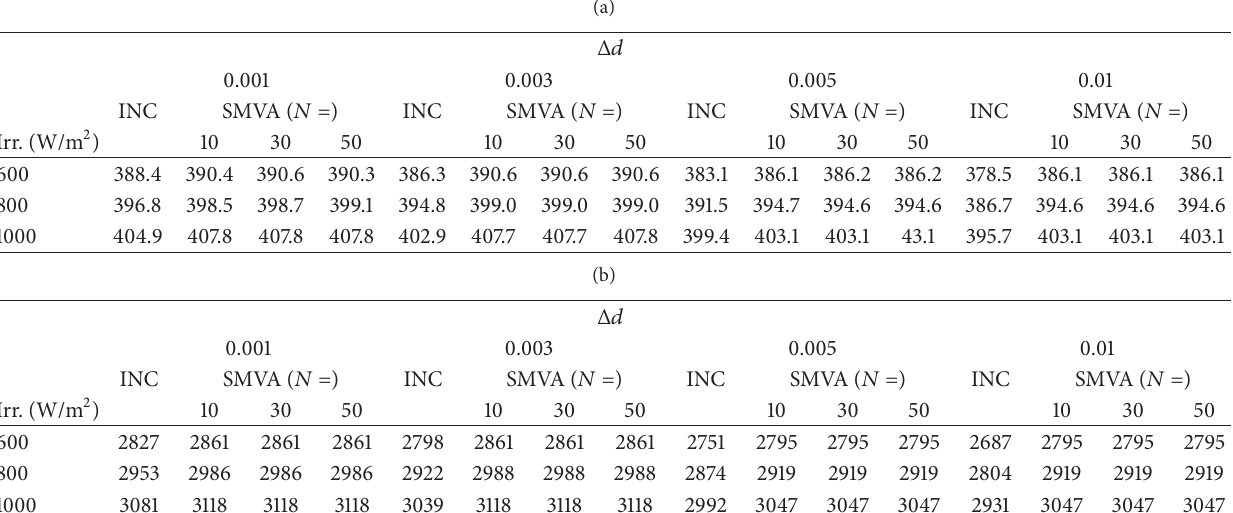
Table 3: (a) Output voltage comparisons between INC and SMVA at different Δ𝑑 and 𝑁 . (b) Output power comparisons between INC and SMVA at different Δ𝑑 and 𝑁